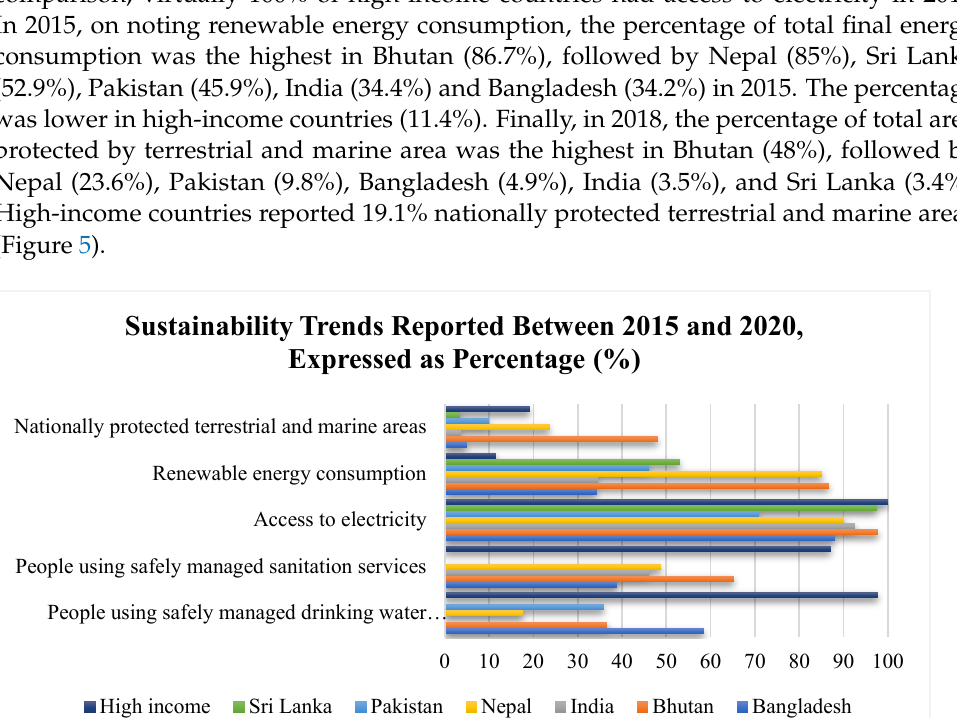
Figure 5. Sustainability Trends reported in the years between 2015 and 2020 reported as a percent- age [18–20].